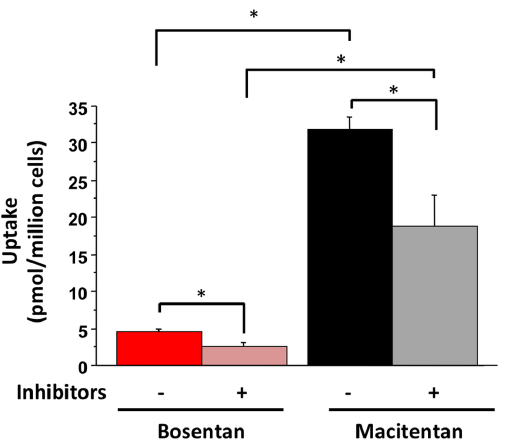
Figure 5. Uptake of bosentan and macitentan into human hepatocytes. ERAs were evaluated either in the absence or presence of the transporter inhibitors rifampicin (40 m M) and cyclosporin A (5 m M). Data presented as mean ( 6 SD) pmol/million cells; n=4 donors; *P , 0.05 for comparisons indicated.